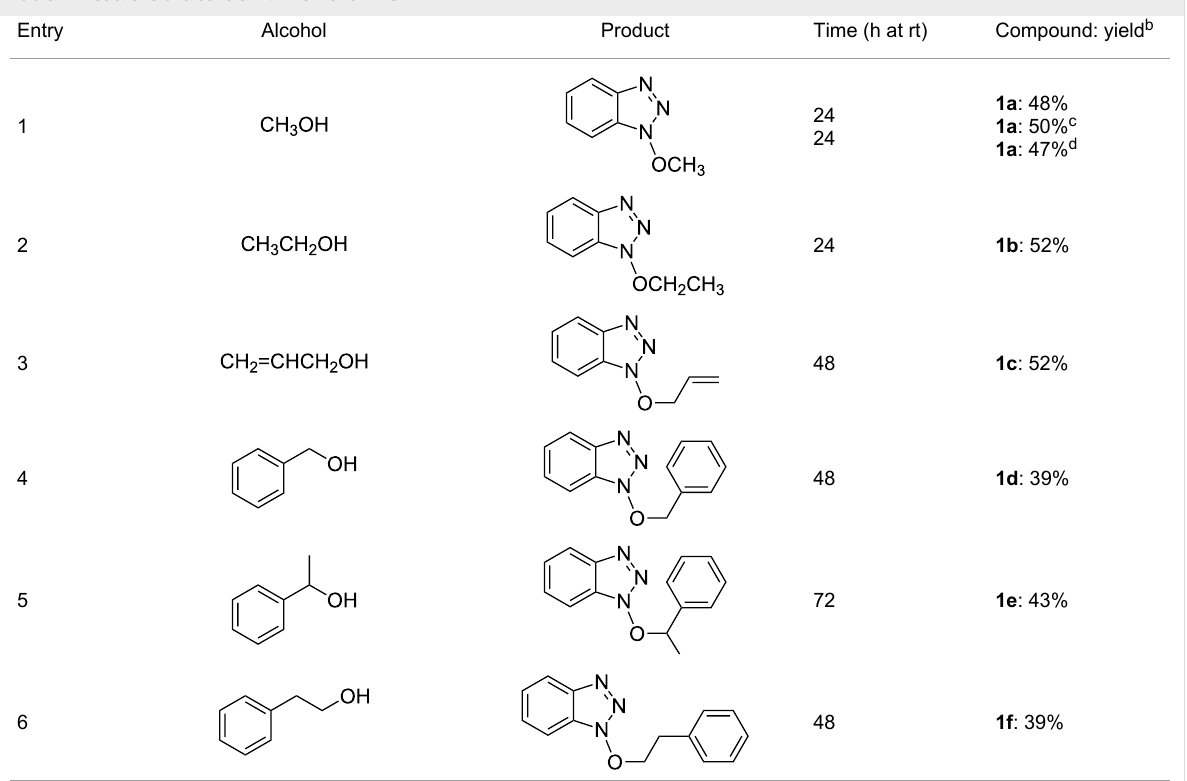
Table 1: Reactions of alcohols with BOP and DBU. a